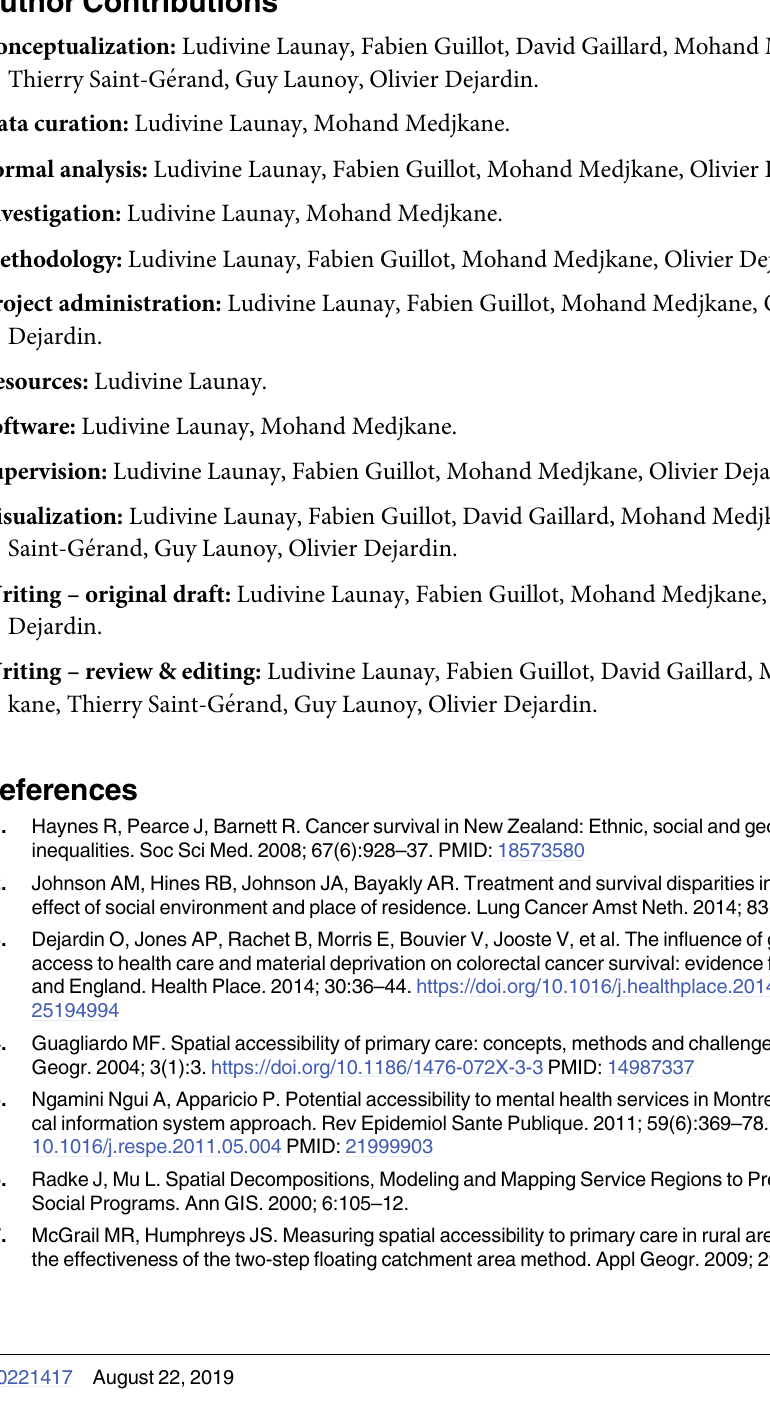
S1 Fig. Sensitivity analysis—Accessibility index of health care (respectively with Euclidean, Minkowski and road network distances) in a major metropolis: The example of Lyon.